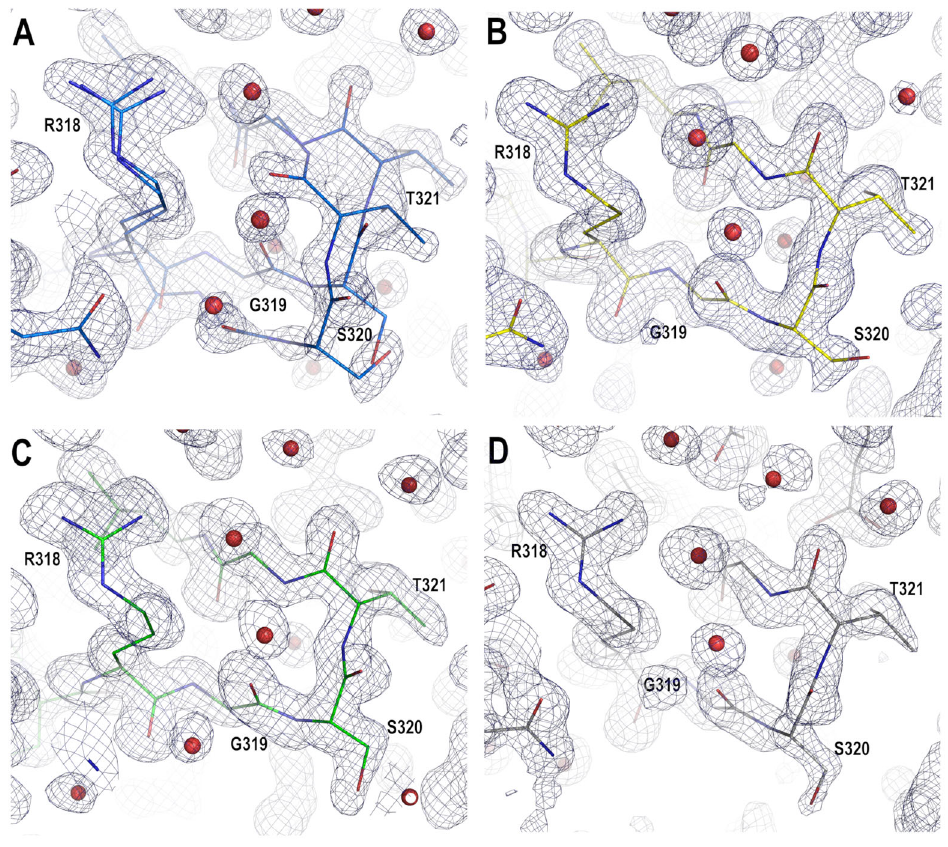
Figure 3. Difference electron density map |2Fo-Fc| countered to 1 σ of the β -turn comprising residues Arg318-Gly322, represented as sticks, of the ( A ) orthorhombic-A (blue), ( B ) orthorhombic-B (yellow) and monoclinic chains ( C ) A (green) and ( D ) B (grey). In the orthorhombic-A, residues Arg318 ‐ Gly322 have been modelled in double conformation.